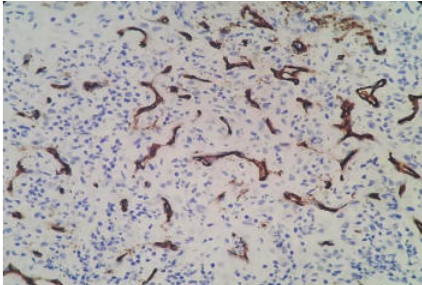
Figure 7: H&E 10x view vascular stroma with multinucleated giant cells.